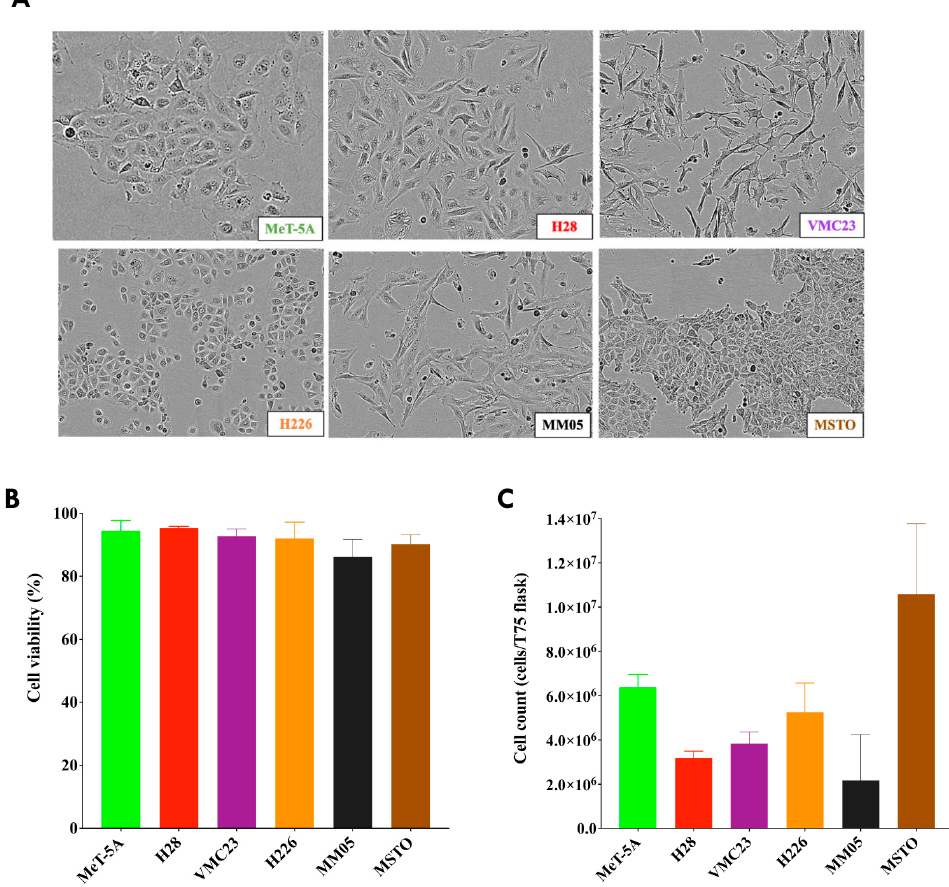
Figure 1. Mesothelioma cell lines. ( A ) Cell morphology monitored every 2 h via light microscopy using real time in vitro IncuCyte ® zoom imaging system; ( B ) Percentage of live cells recorded on a Countess live cell counter after the starvation period and just before EVs were isolated. ( C ) The number of cells in a T75 flask for each cell line after the starvation period and just before EVs were isolated, recorded on a Countess live cell counter. Data for cell viability and cell counts were calculated from an average of three T75 flasks for each cell line just before EV isolation.